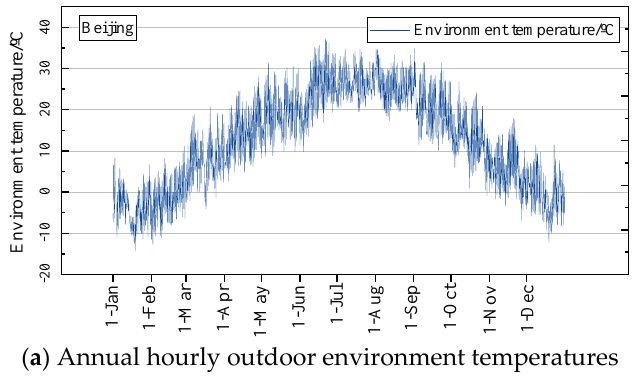
Figure 23. Architectural plan and perspective of the case study data center (DC).